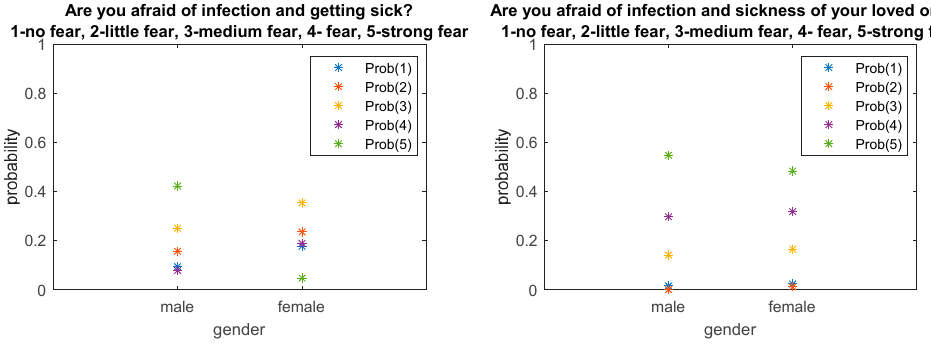
Figure 5. Response probability distributions depending on the age and sex of the respondents.